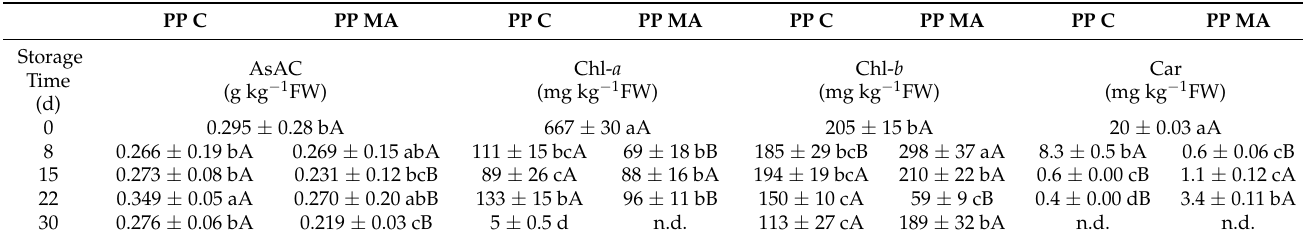
Table 2. Effect of the “packaging (P) x storage time (S)” significant interaction on ascorbic acid content (AsAC), chlorophyll- a (Chl- a ), chlorophyll- b (Chl- b ), and carotenoid (Car) in PP C (micro-perforated polypropylene bags) and PP MA (polypropy- lene macro-perforated bags).